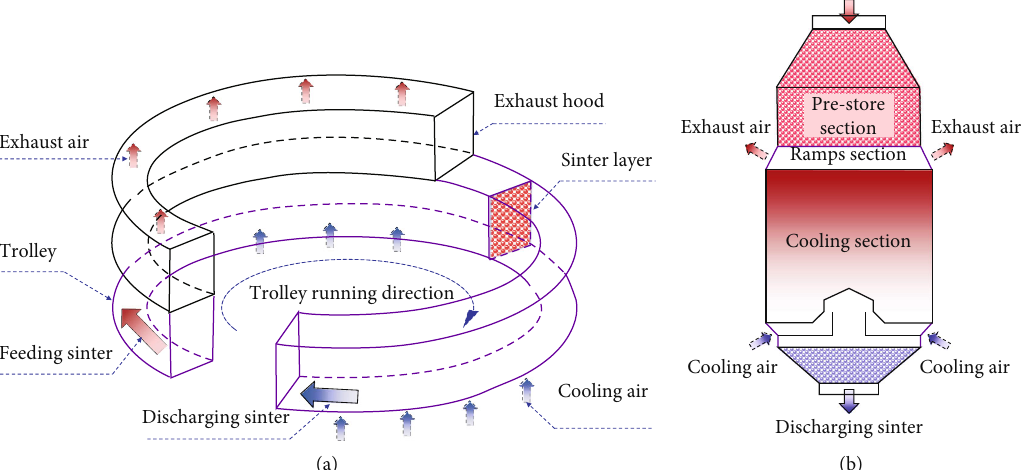
Figure 1: Comparison of two kinds of the sinter waste heat recovery processes: (a) annular cooling process; (b) vertical cooling